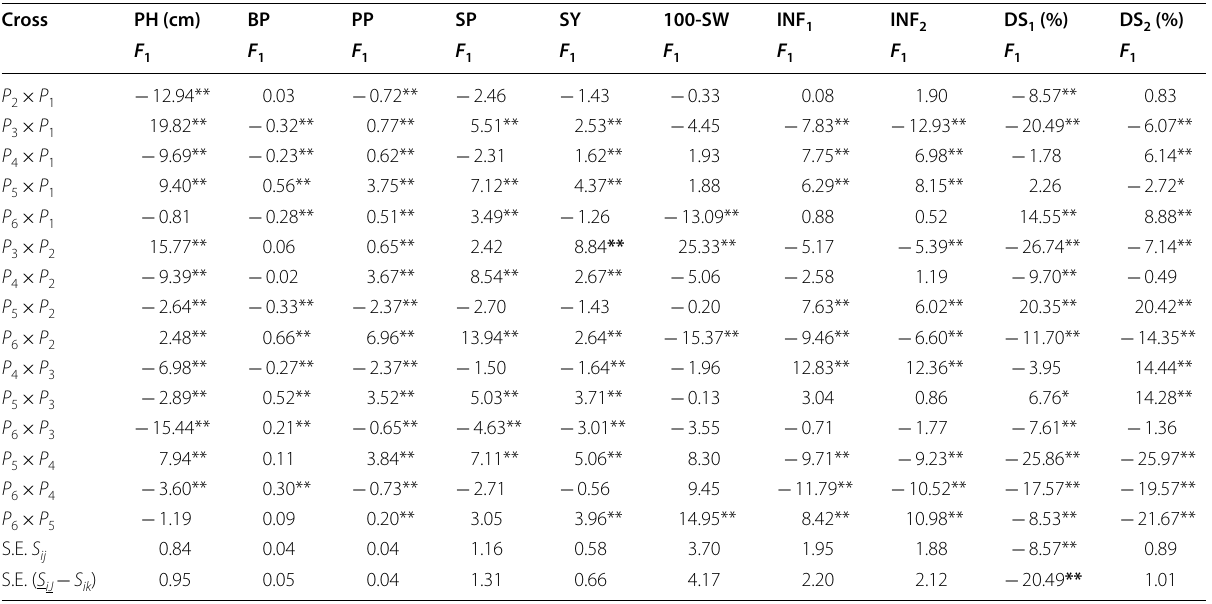
) of diallel crosses for studied traits of F ij